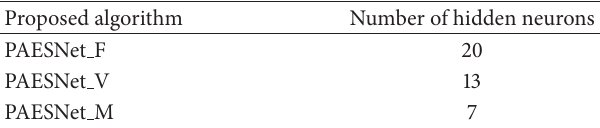
Table 3: The best evolved networks from proposed algorithms.